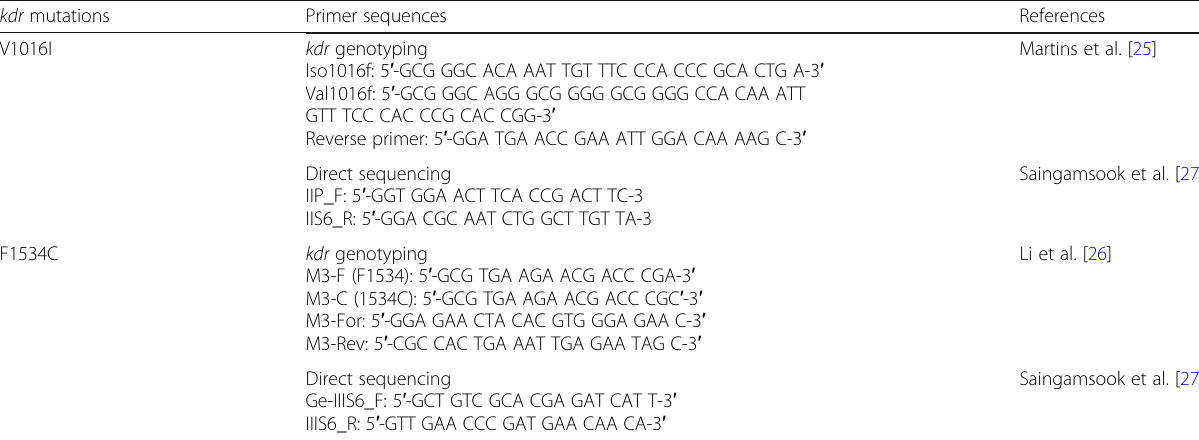
Table 1 List of primer sequences used for detecting allele-specific kdr mutations and direct sequencing of the sodium channel regions encompassing these mutations kdr mutations Primer